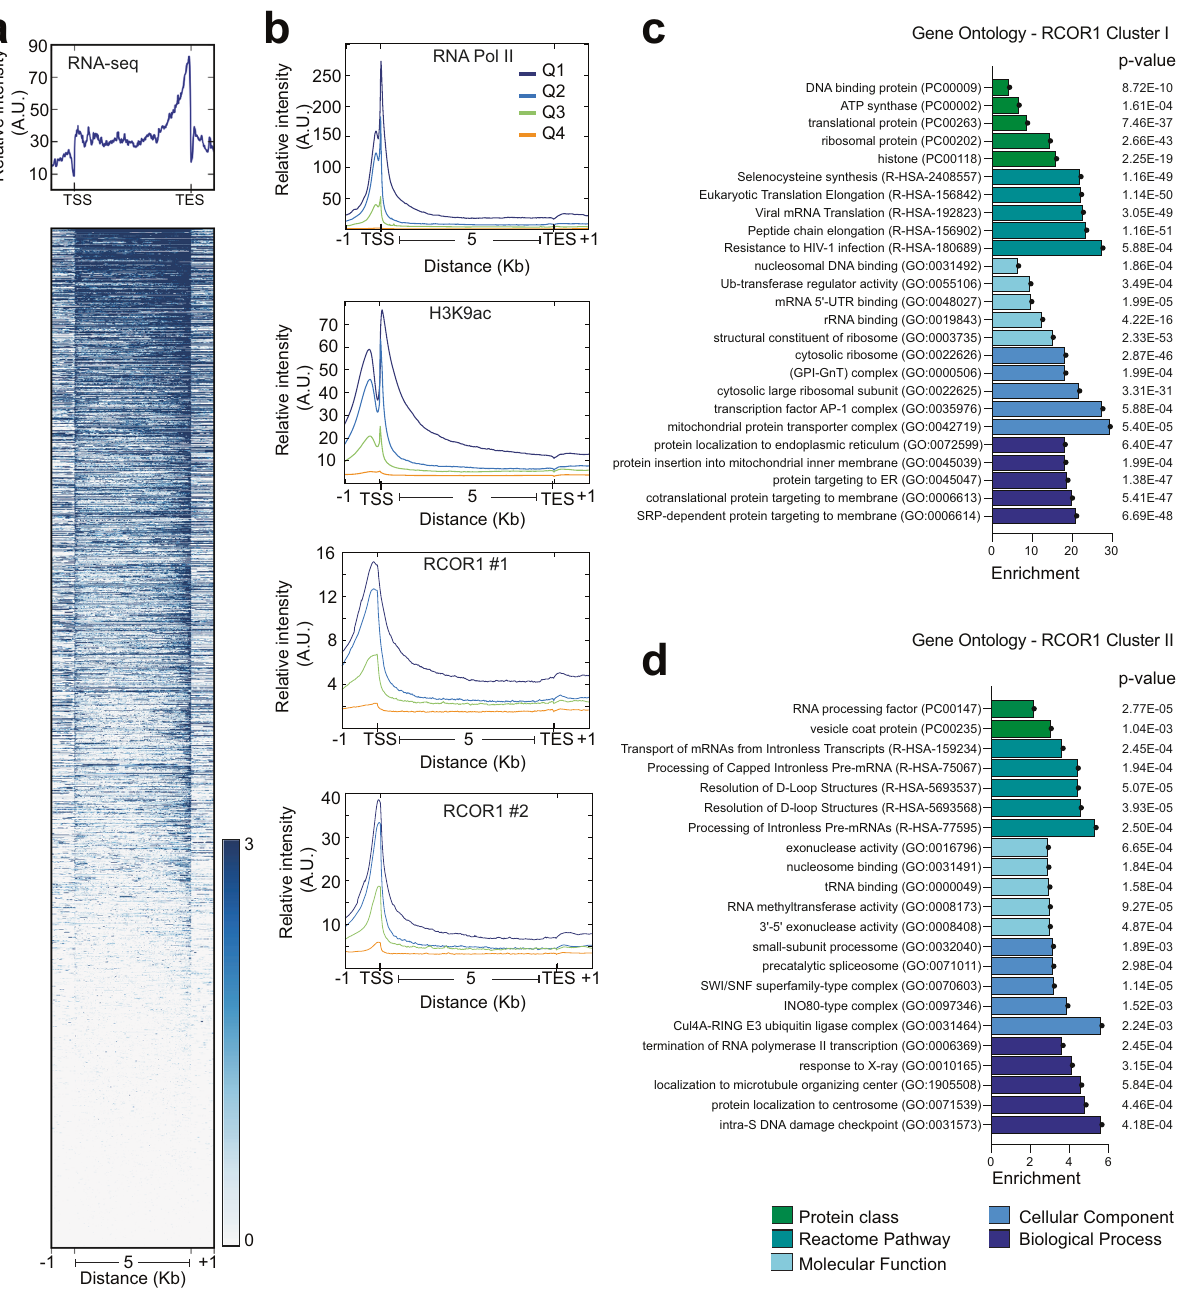
Fig. 4 RCOR1 occupancies are positively correlated with gene expression. a Meta-gene plots of RNA-seq data in K562 cells. Lower diagram shows the heatmap of the signal intensity from RNA-seq data sorted by intensity. b Quartile-based comparison of relative RNA POL-II, H3K9ac, and RCOR1 occupancies on the genes in different quartile groups based on RNA-seq signal intensity. Two different RCOR1 datasets (using different antibodies) were analyzed (labeled as #1 and #2). c and d Gene ontology analysis of RCOR1 clusters I and II, respectively. Bar colors represent different ontology categories, highlighted at the